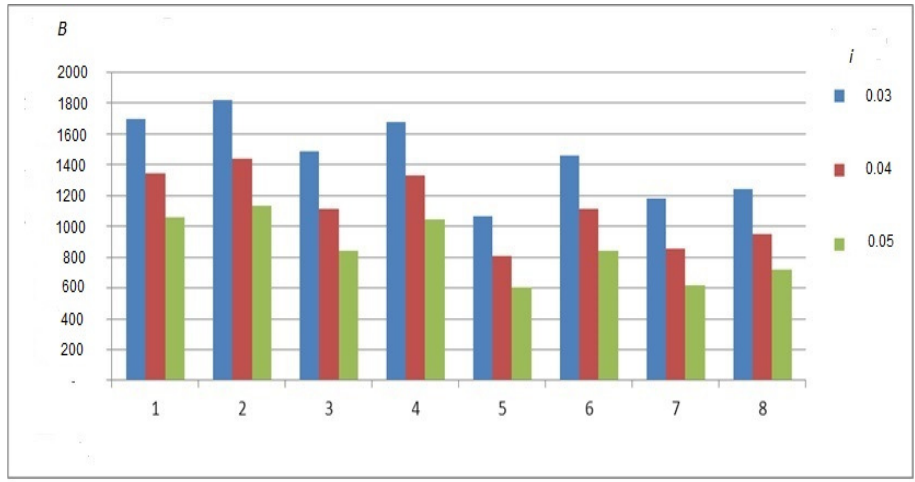
Figure 6. Gross premium size for males and females.